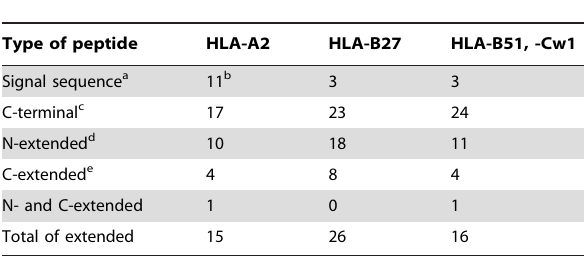
Table 2. Major features of TAP-independent HLA ligands.